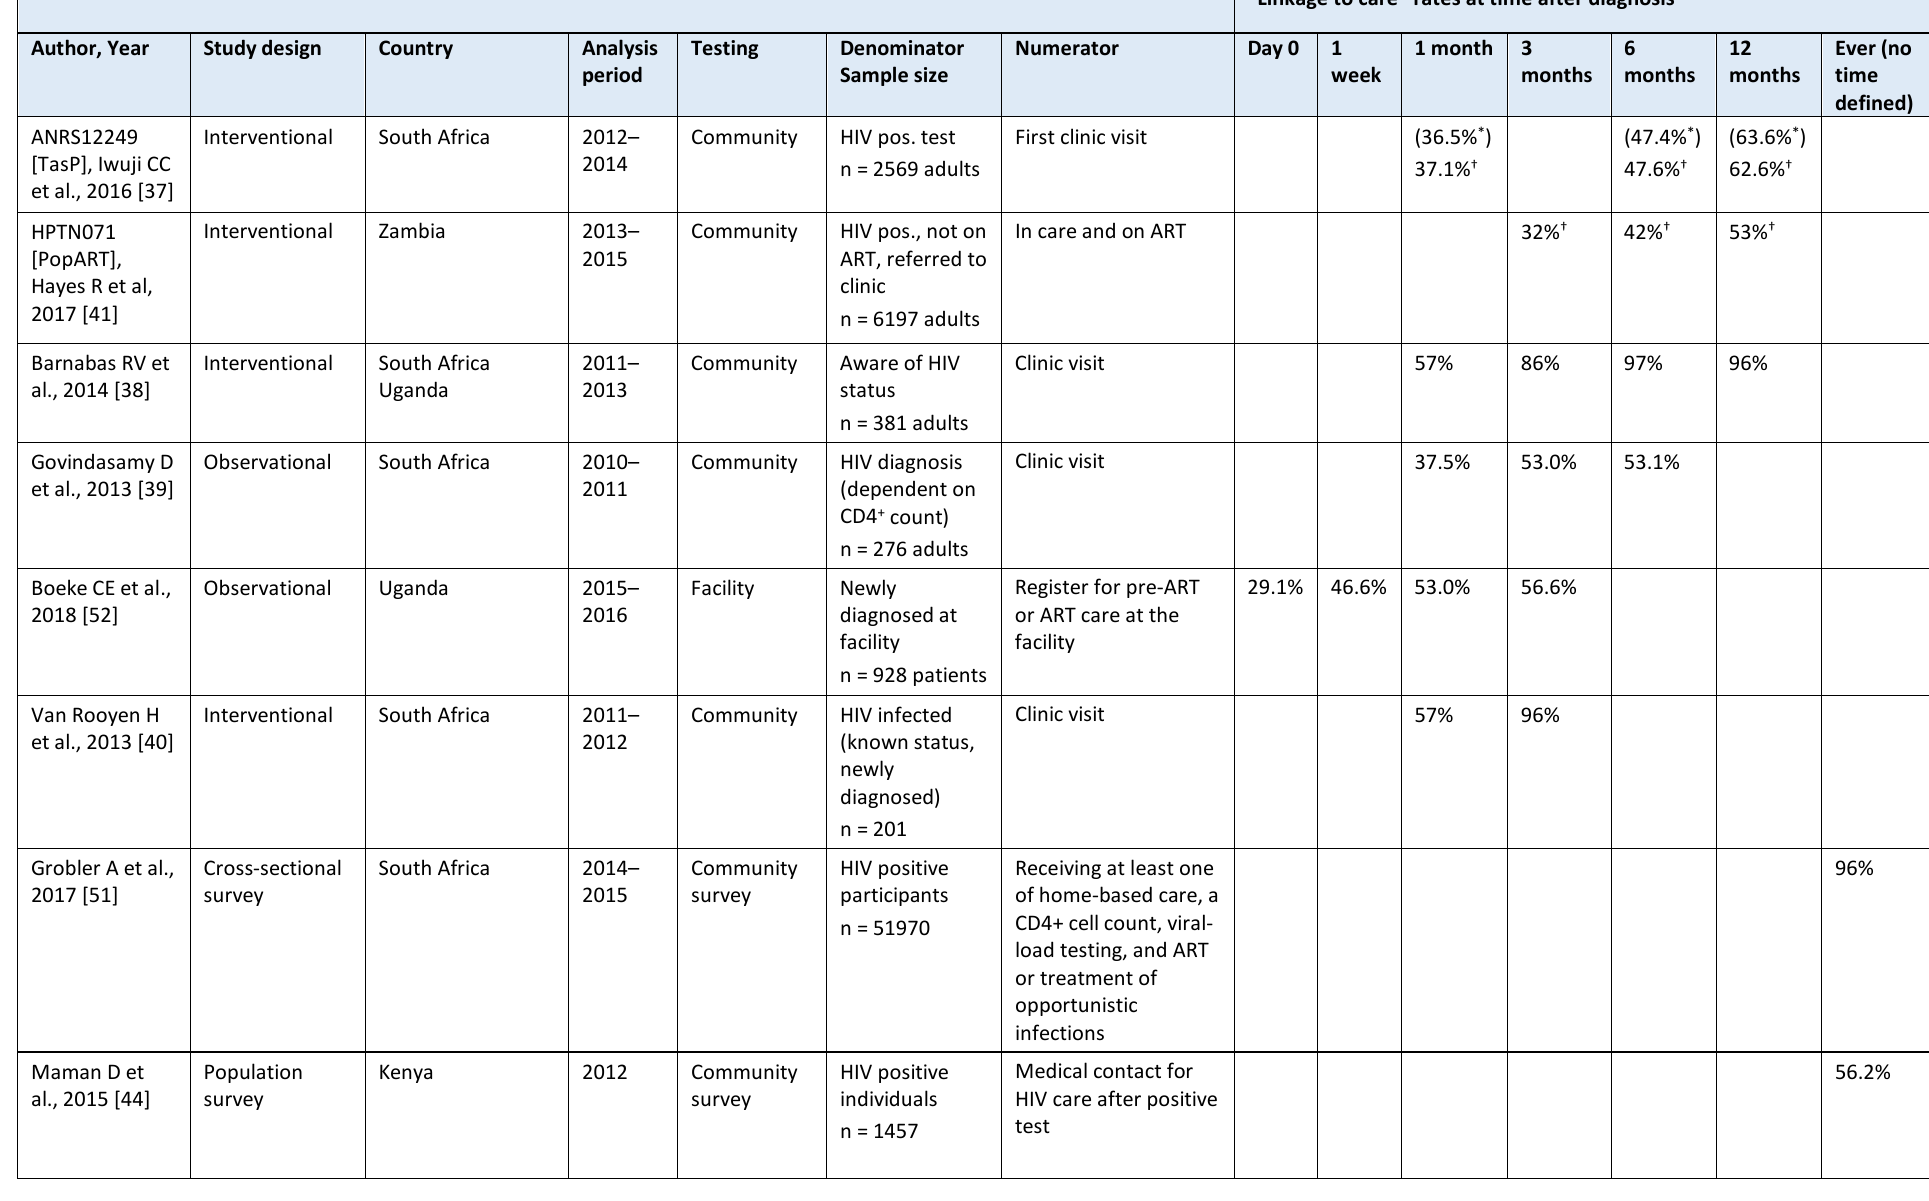
“Linkage to care” rates at time after diagnosis